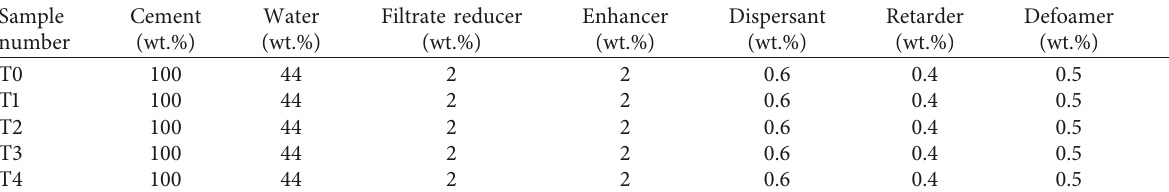
Table 1: Slurry samples with different TPR contents.